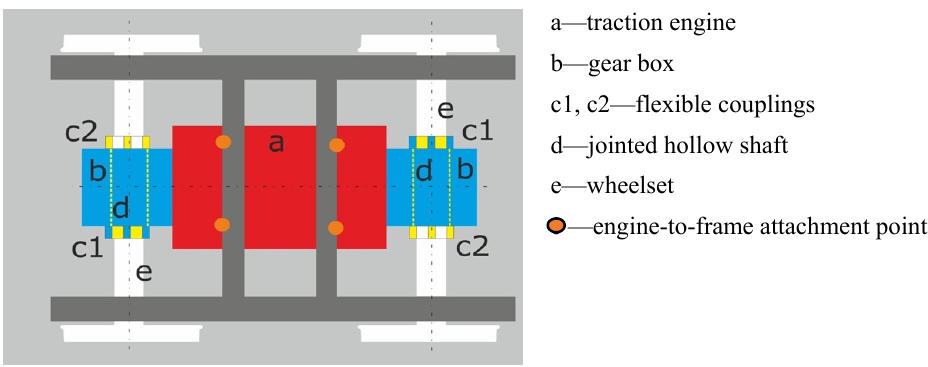
Figure 3. Drive system with a longitudinally mounted motor on the bogie frame and the use of a hollow shaft gearbox and flexible couplings, source: www.transportszynowy.pl, (accessed on 20 June 2022), website owner: Maciej Górowski.